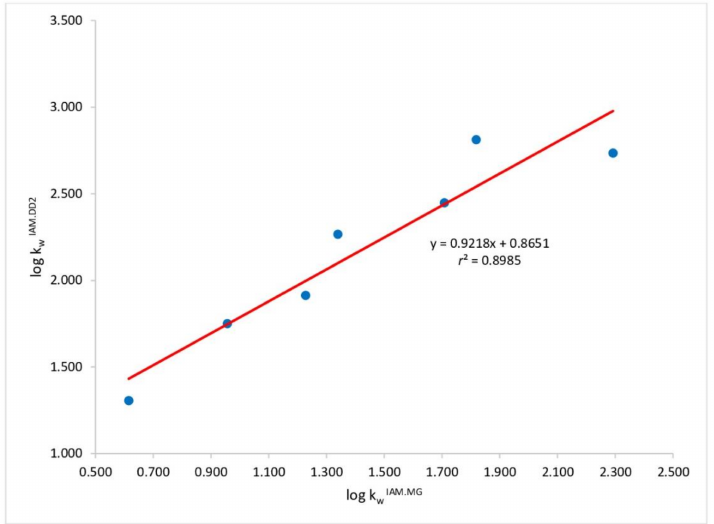
Figure 2. Relationship with phospholipophilicity data achieved on IAM.PC.MG and IAM.PC.DD2 stationary